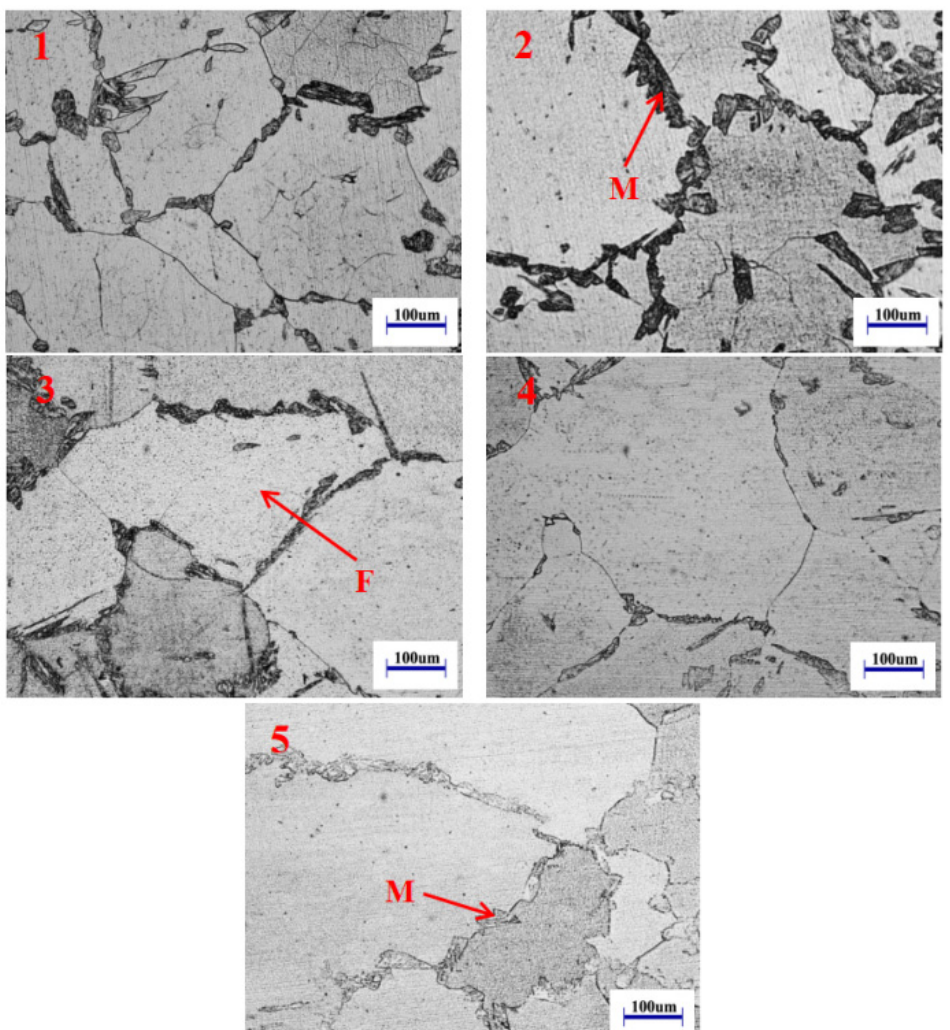
Figure 11. Microstructure of coarse grain zone at different heat treatment temperatures: ( 1 ) as-welded, ( 2 ) 720 °C, ( 3 ) 770 °C, ( 4 ) 820 °C, ( 5 ) 870 °C .